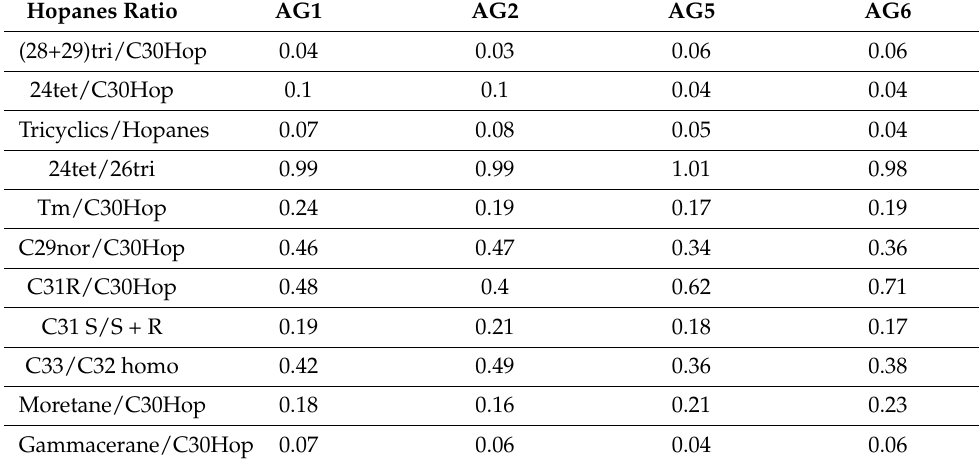
Table 8. Hopanes geochemical indices.